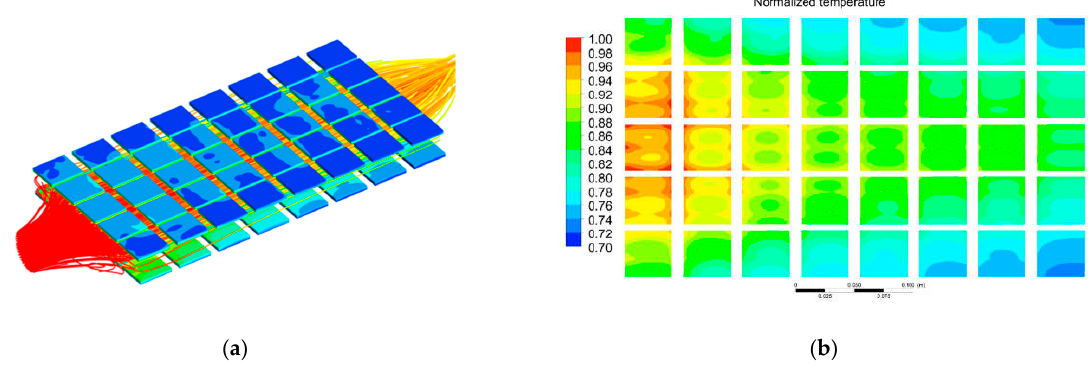
Figure 3. ( a ) 3-D reconstruction of the internal flow and the thermoelectric modules and ( b ) normalized temperature in upper-surface modules.